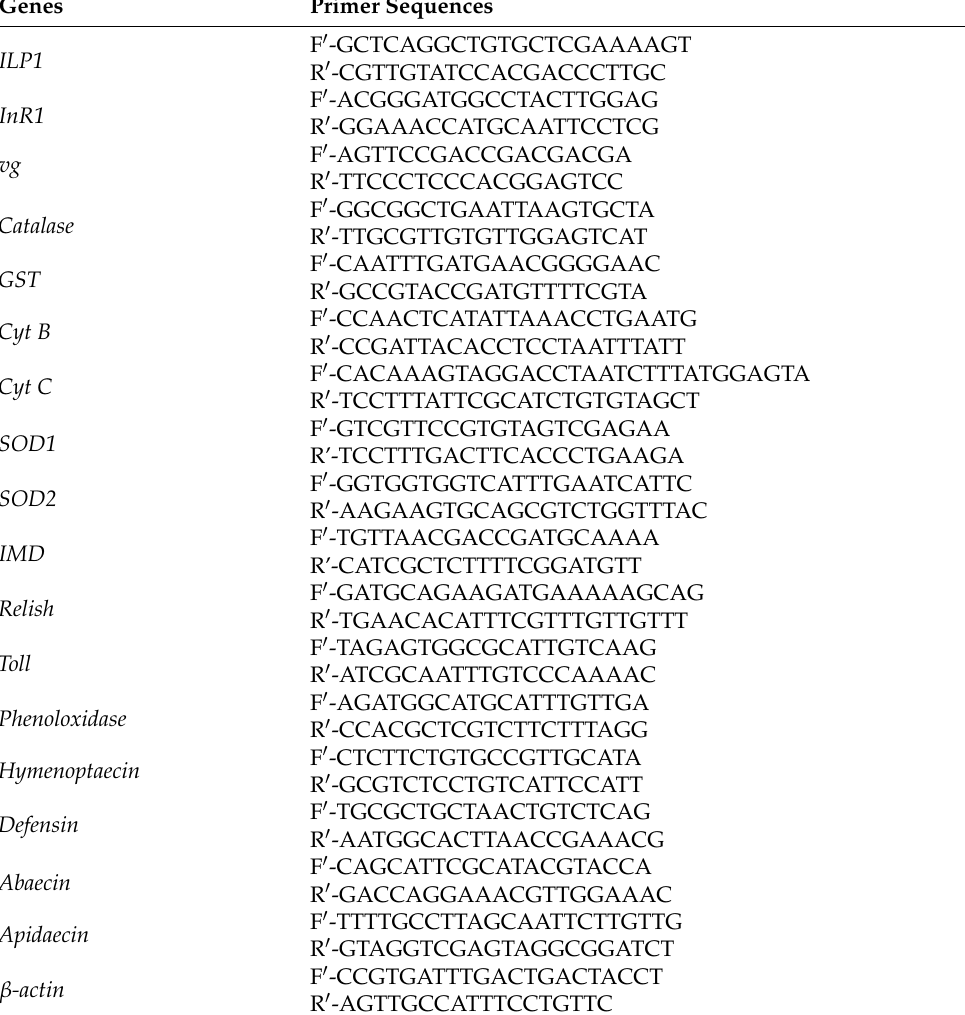
Table 1. Primer sequence for